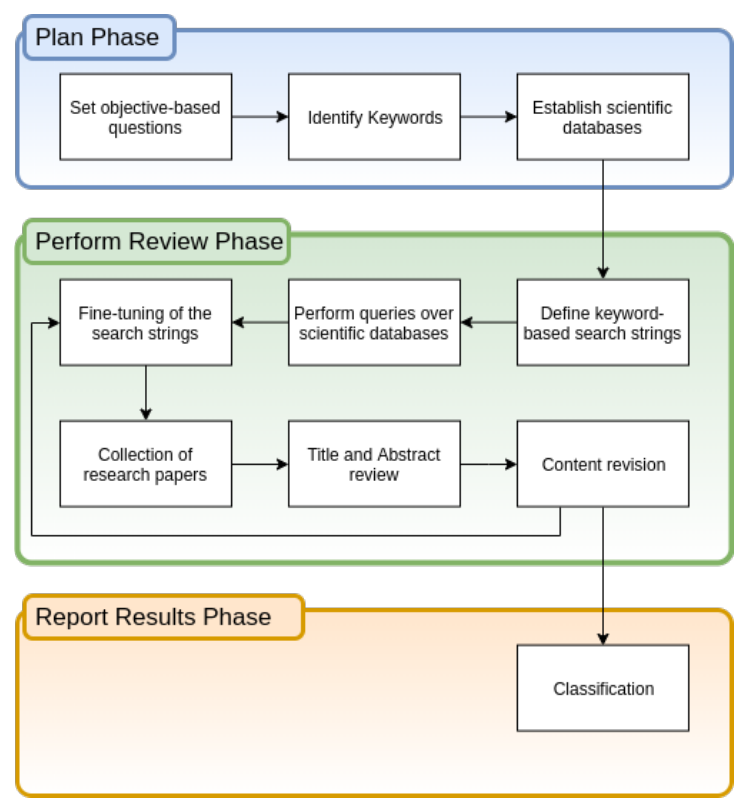
Figure 1. Detailed research